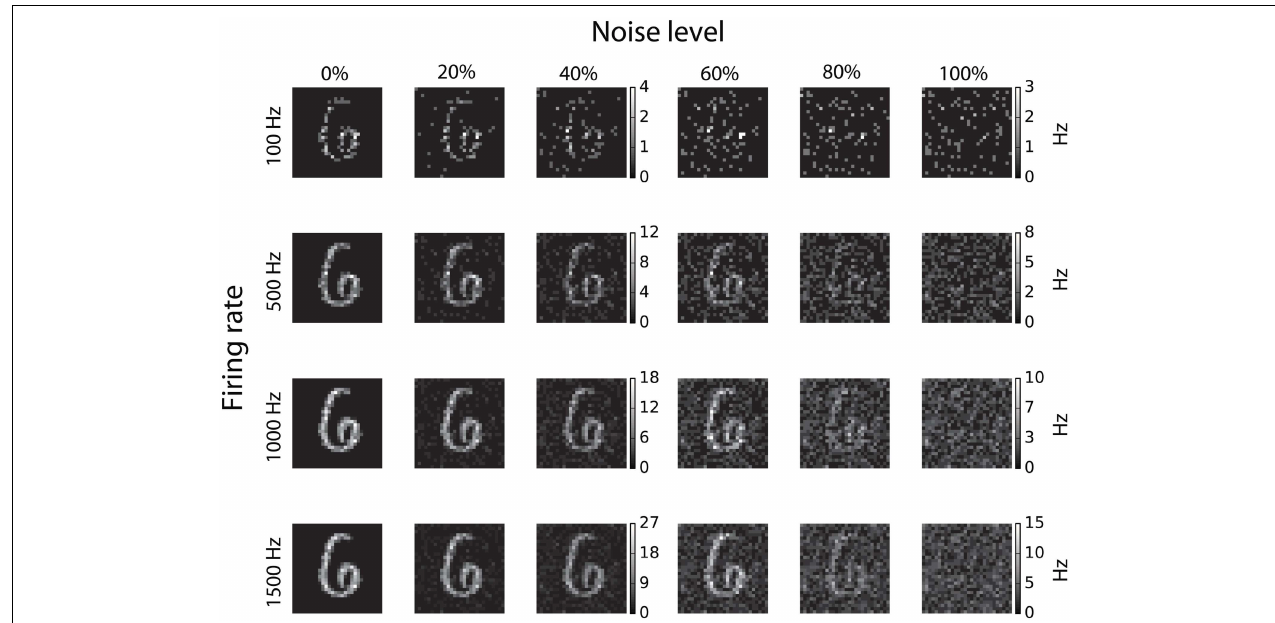
FIGURE 2 | Conversion of static images to spike-trains and introduction of noise. Each row represents different input rates ranging from 100 to 1500Hz, while the columns show different percentages of input noise, from 0 up to 100%.